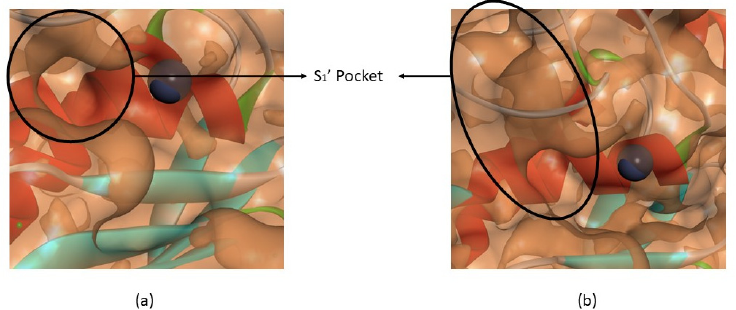
Figure 2. ( a ) Active site of MMP-1. ( b ) Active site of MMP-13. The S 1 ′ pocket of MMP-1 is shallow and the S 1 ′ pocket of MMP-13 is deep.